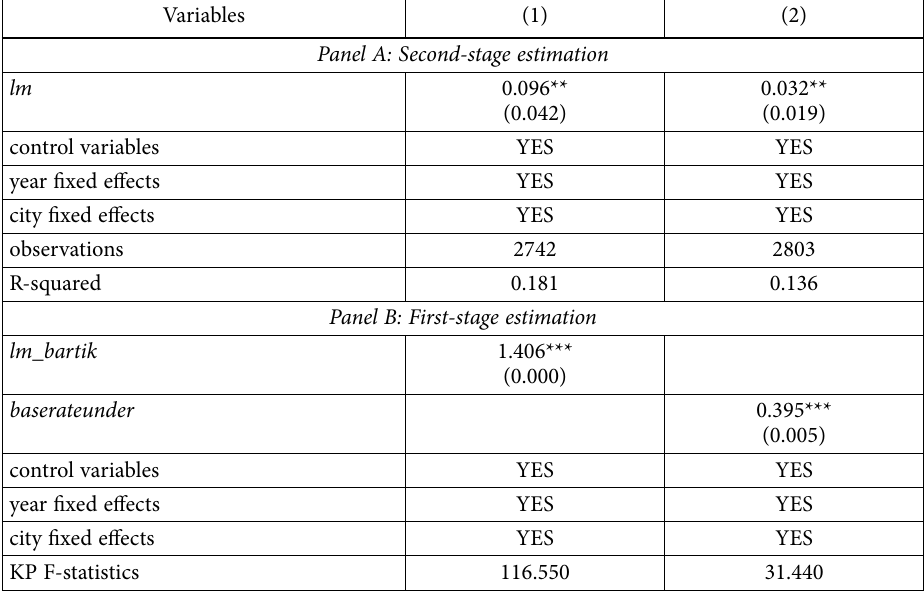
Table 6. 2SLS estimation